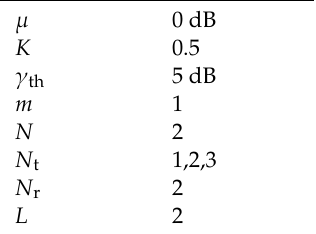
Figure 4. The OP performance of the transmit antenna selection (TAS) scheme. Table 1. The parameters for the TAS scheme.